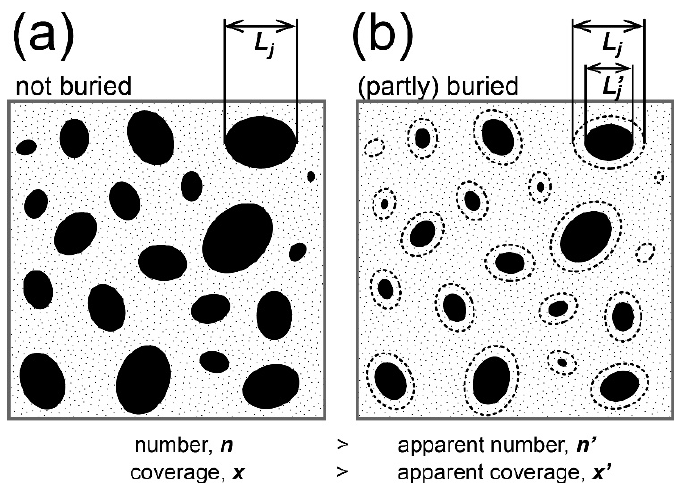
Figure 1. Schematic illustrations of manganese nodules on the deep seafloor (original illustration is from [13]). ( a ) Nodules not covered by sediments (or with a lower degree of burial). ( b ) Nodules heavily covered by sediments (or with a higher degree of burial). In case ( b ), the apparent long axis of large nodules ( L j ′ ) becomes smaller than that of original nodules ( L j ), and small nodules are completely buried ( j means an identified number). The dotted circles surrounding each nodule show the outlines of unburied nodules. Further, comparing between ( a ) and ( b ), apparent number ( n’ ) and coverage ( x’ ) of nodules per area unit also become smaller than those of original nodules ( n, x ), respectively.